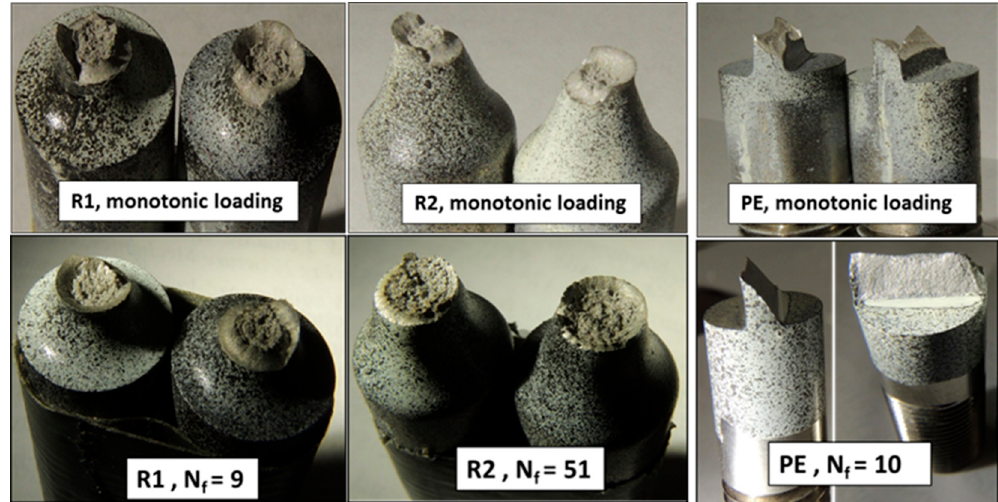
Figure 14. Similar fracture modes under different loading conditions of ductile fracture and ELCF. The upper row illustrates fracture surfaces due to ductile fracture and the lower row are due to ELCF. Reproduced from Reference [1], with permission from Elsevier, 2019.